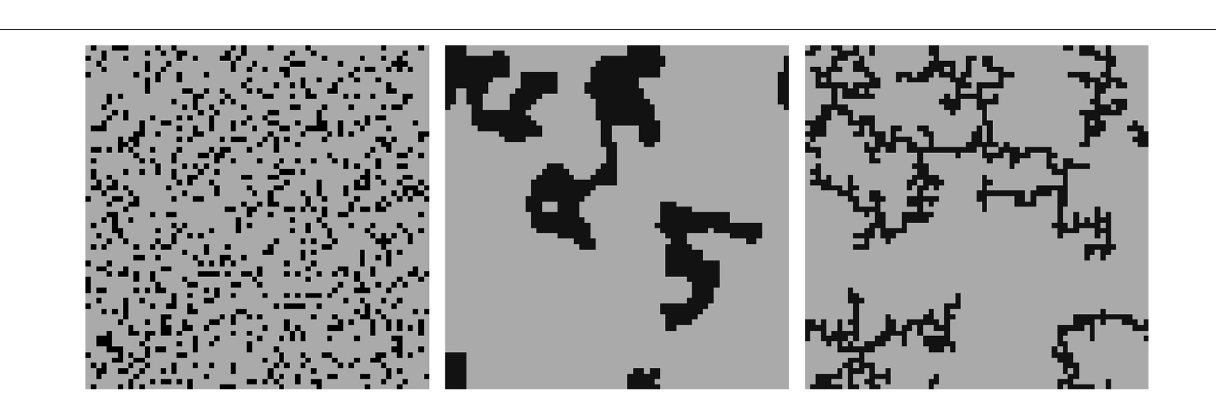
FIGURE 8 | Self organization depending on shape and size constraints: (Left) Initial random configuration with single solid cells (top) and needles (bottom) in black with porosity θ = 0.5; (Right) Quasi-stationary states with a stencil of 1.